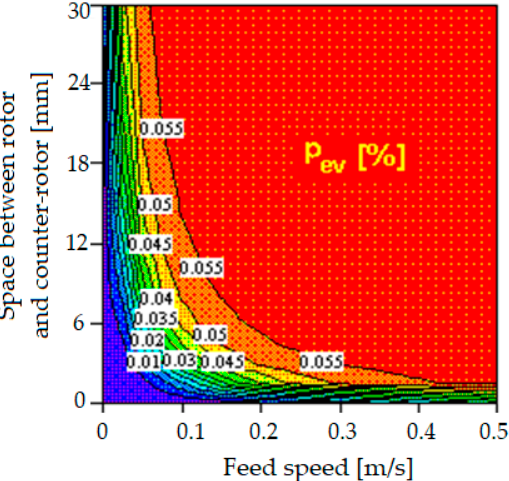
Figure 12. Graphical representation of evacuation losses ( p ev ) as a function of feed speed ( v a ) and space between rotor and counter-rotor ( δ